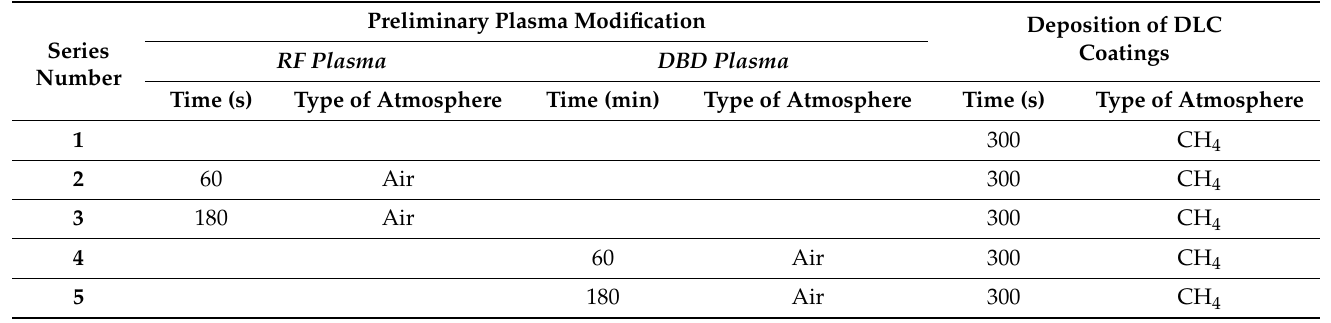
Table 1. Parameters of modification